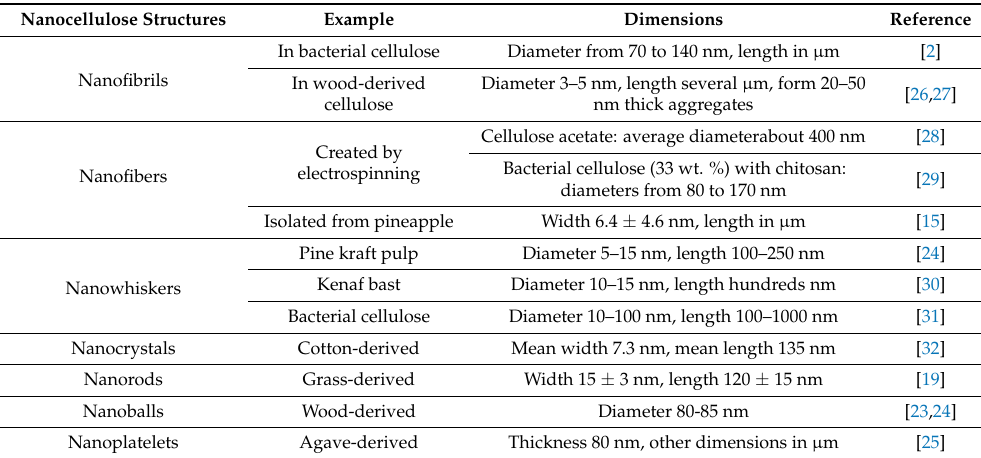
Table 1. Types of